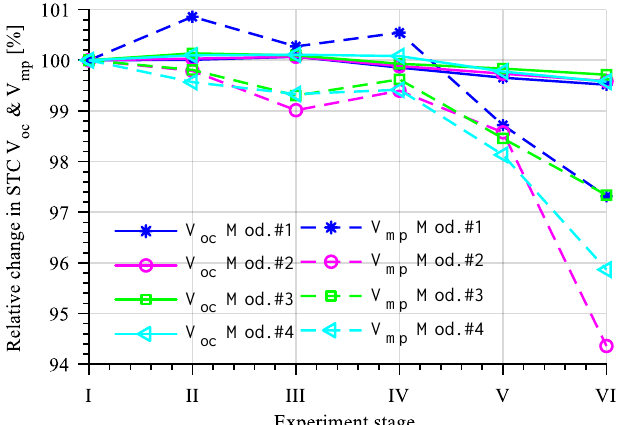
Figure 5. Relative change in the STC open-circuit and maximum power point voltages of the four modules during the six stages of the experiment—described in Table